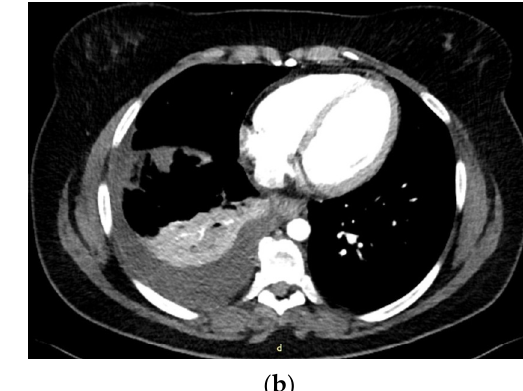
( b ) Figure 2. ( a ) Post-aortoiliac bypass arteriographic image; di ff use arterial calci fi cations; and ( b ) 3D reconstruction of arteriographic image of aortoiliac bypass. The cardiologist recommended throm- bophilia re-evaluation. The screening for acquired thrombophilia—including anti-cardiolipin IgM and IgG antibodies and lupus anticoagulant factor—was negative. Protein C, protein S, homocyste- ine and antithrombin levels were tested, with no signi fi cant changes detected. Factor V Leiden and prothrombin gene mutation were absent. Thus, the inherited thrombophilia diagnosis could not be sustained. The patient was redirected to the vascular surgery department for revascularization. At discharge, antiplatelet therapy (acetylsalicylic acid, 75 mg daily), antihypertensive therapy (can- desartan, 16 mg daily), proton pump inhibitor therapy (pantoprazole, 20 mg daily), statin therapy (atorvastatin, 10 mg daily), and cilostazol (100 mg daily) were prescribed. The patient underwent